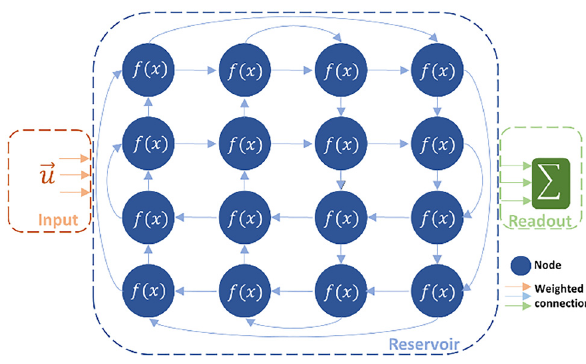
Figure 1: RNNs are networks with feedback connections where all connections are trained. For RC, the network is split into a reservoir layer where connections are untrained, and a readout layer with trainable connections. The readout signals, which can be taken from any and all the reservoir nodes, are summed to generate the